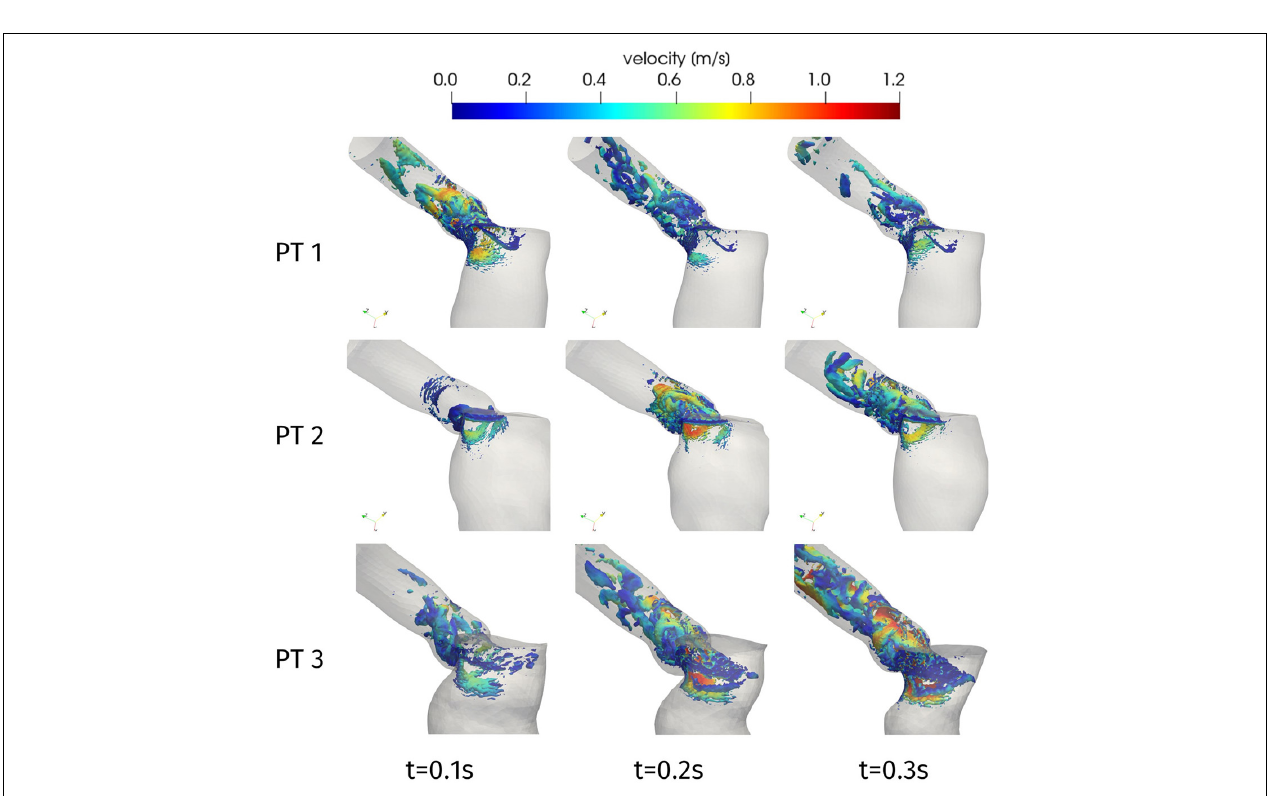
Frontiers in Physiology |